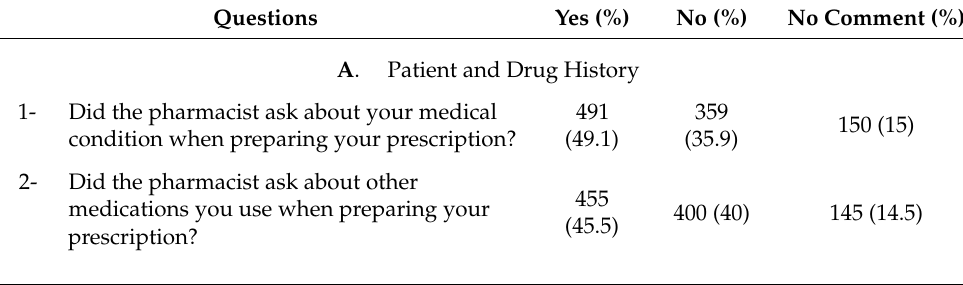
Table 4. Responses to Questions on the Clinical Roles of Community